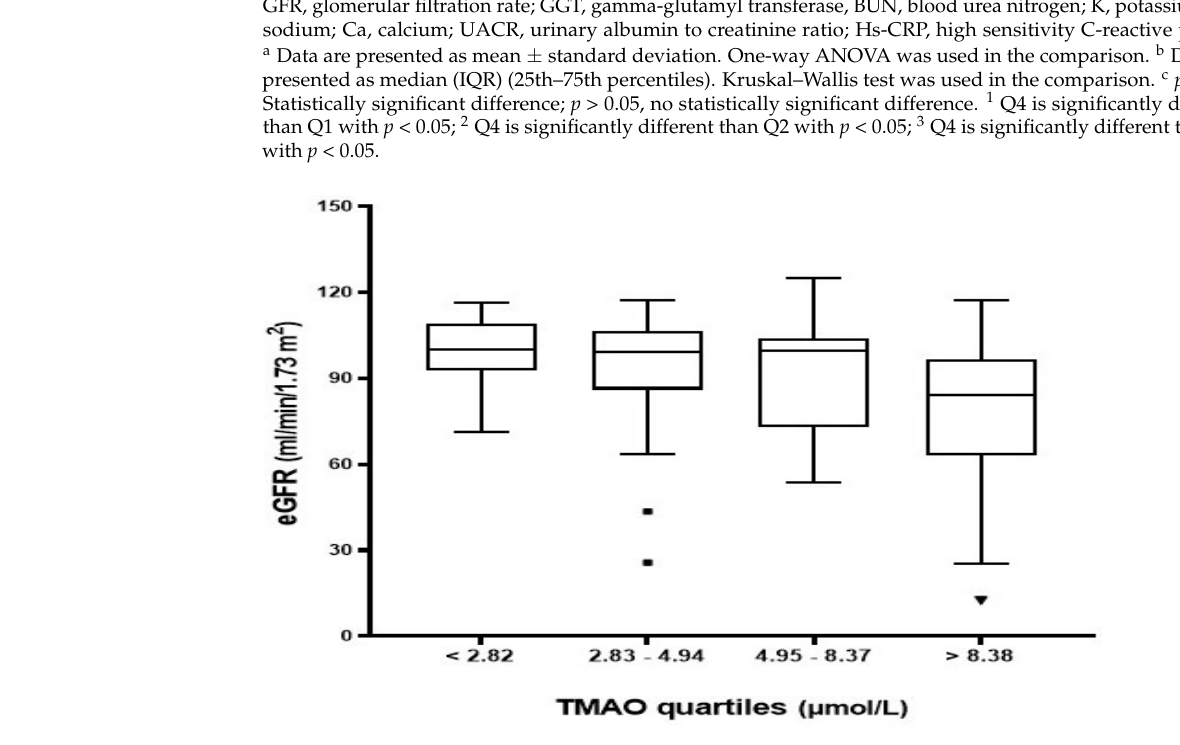
Figure 1. Estimated GFR distribution across plasma TMAO quartiles. Q1(<2.82), Q2 (2.83–4.94), Q3